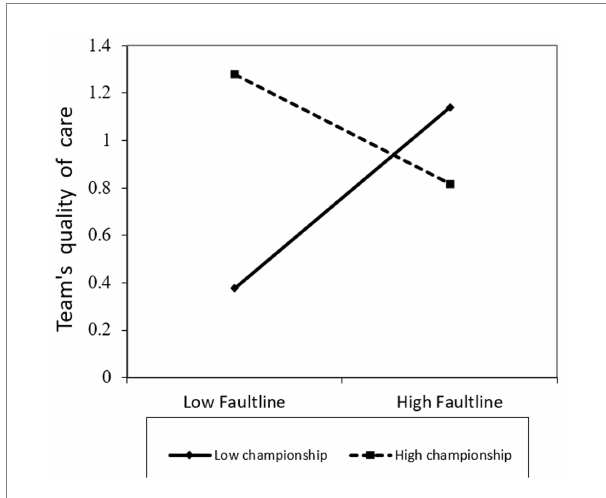
FIGURE 2 Team’s quality of care, by faultlines and championship behaviors.